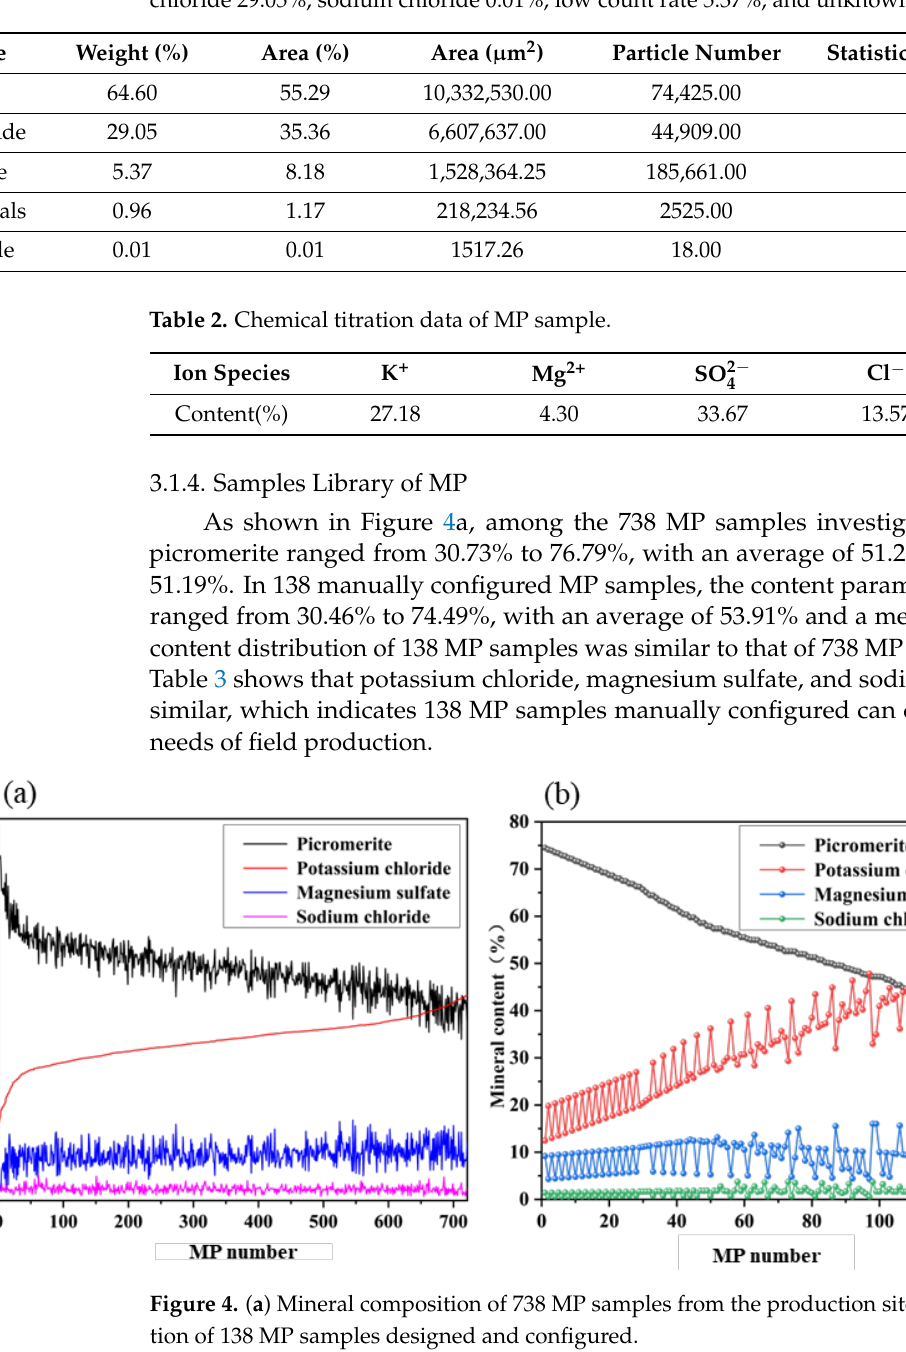
Table 1. MLA analysis of the MP sample showed that picromerite accounted for 64.60%, potassium